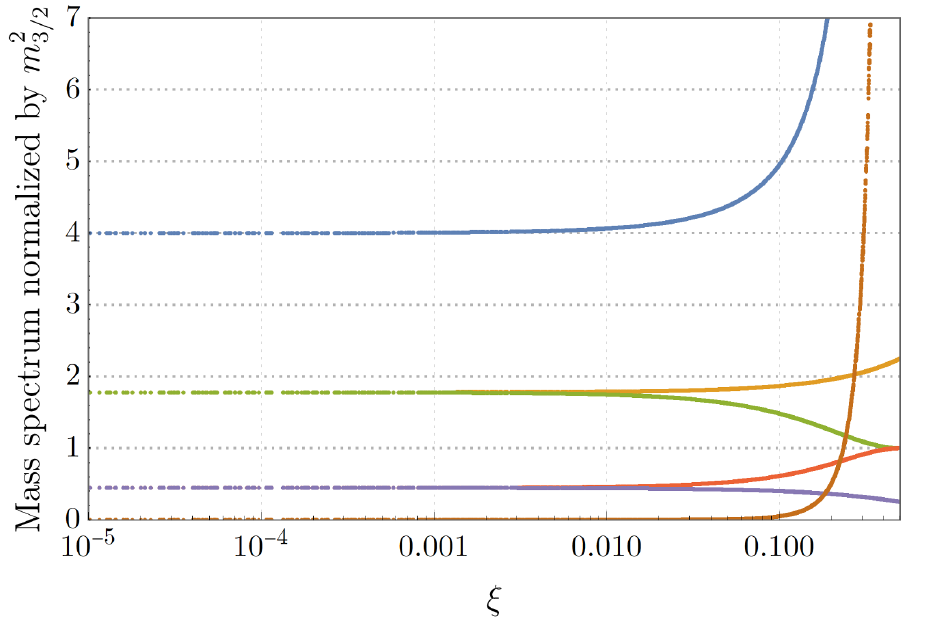
Figure 5 . This plot shows the squared masses, normalized by the gravitino mass squared, numerically obtained in the set of vacua. They precisely reproduce the analytical behaviour (4.54) displayed in figure